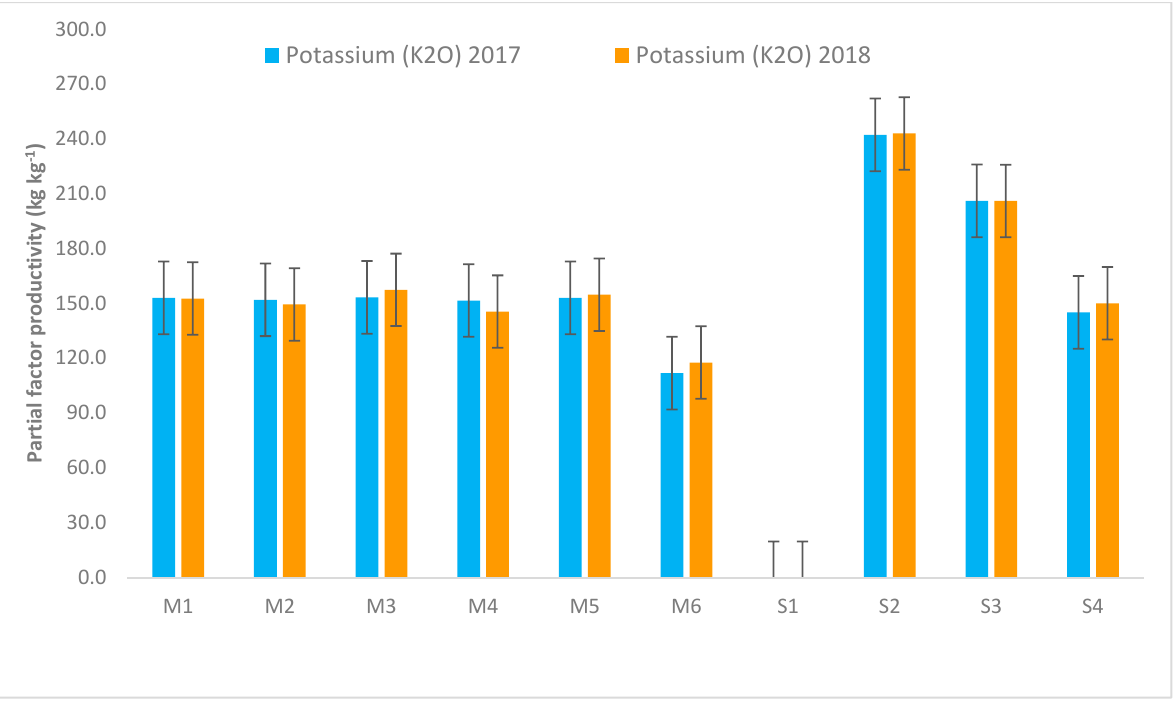
Figure 1. The partial factor productivity of the paddy landraces, as influenced by different fertility levels in conjunction with biofertilizers during 2017 and 2018. M: Landraces; M 1 : Hal doddiga; M 2 : Mysore sanna; M 3 : Padmarekha; M 4 : Halga; Kemp jadda Bhatta; M 6: Kari kagga; S: Fertility levels; S1: Farmers practice ; S 2 : 50 % RDF + biofertilizers; S 3 : 75 % RDF + biofertilizers; S 4 : 100 % RDF + biofertilizers; S 4 : 100 % RDF + biofertilizers; M × S: Interaction; Em: Standard Error of Mean; LSD: Least Significant Difference; Biofertilizers include Azospirillum + Bacillus megatherium var. Phosphoticum + Frateuria quaratia + Thiobacillus thiooxidans +Vesicular Arbuscular Mycorrhiza; Farmers Practice include only application of NPK as mentioned in methodology without any biofertilizers; 4. S1 is the considered as control for different fertilization levels. Vertical bar indicates LSD at p = 0.05.